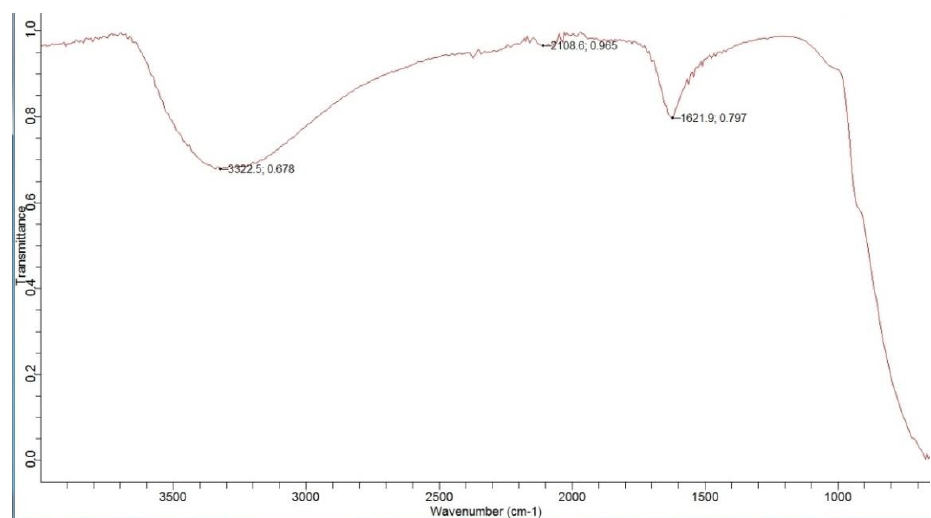
Figure 4. FTIR spectrum of g-C 3 N 4 -MnWO 4.